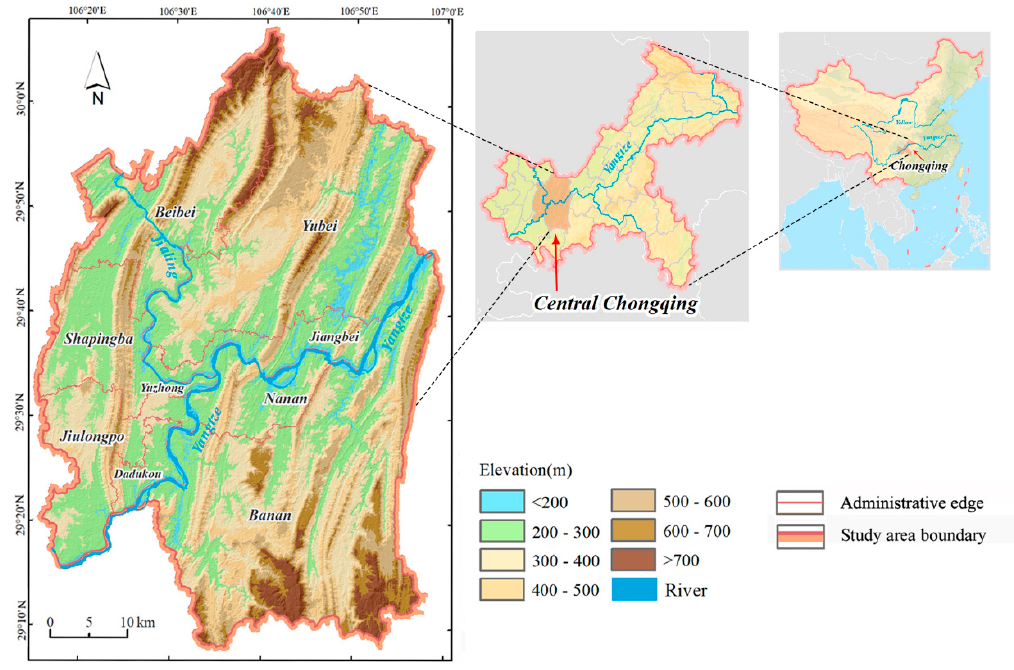
Figure 1. Locations of the nine central districts and Chongqing in China.